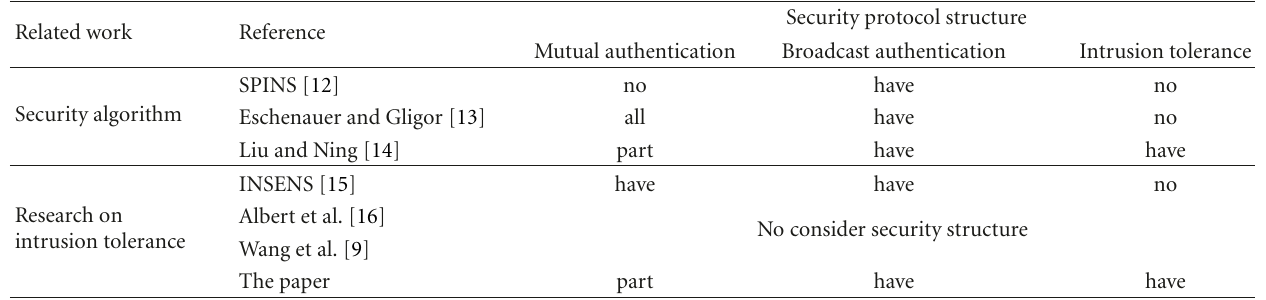
Table 1: Security protocol structure.